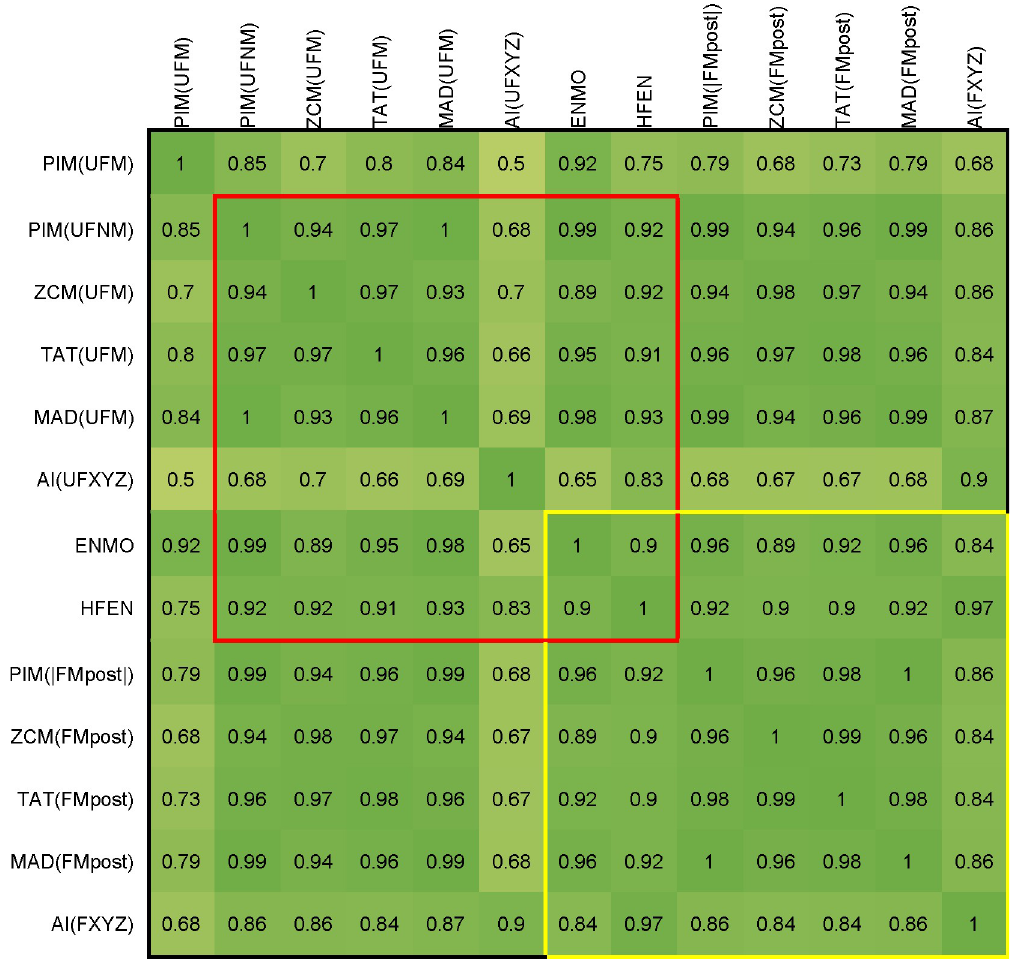
Fig 7. Correlation between activity signals calculated from raw (UFM, UFXYZ) and filtered datasets (FMpost, FXYZ). In addition, we included the PIM metric applied on the UFNM dataset, too. The Pearson’s correlation coefficients are calculated by 42 measurements, and their means are represented. Cells in the red square indicate correlations between activity signals calculated by the unfiltered datasets, and cells in the yellow square include correlations between activity signals calculated by the filtered datasets. Since our goal is to compare all 7 metrics, but no filtering is possible in the case of ENMO, and as HFEN demands a specially filtered dataset, we included them in both